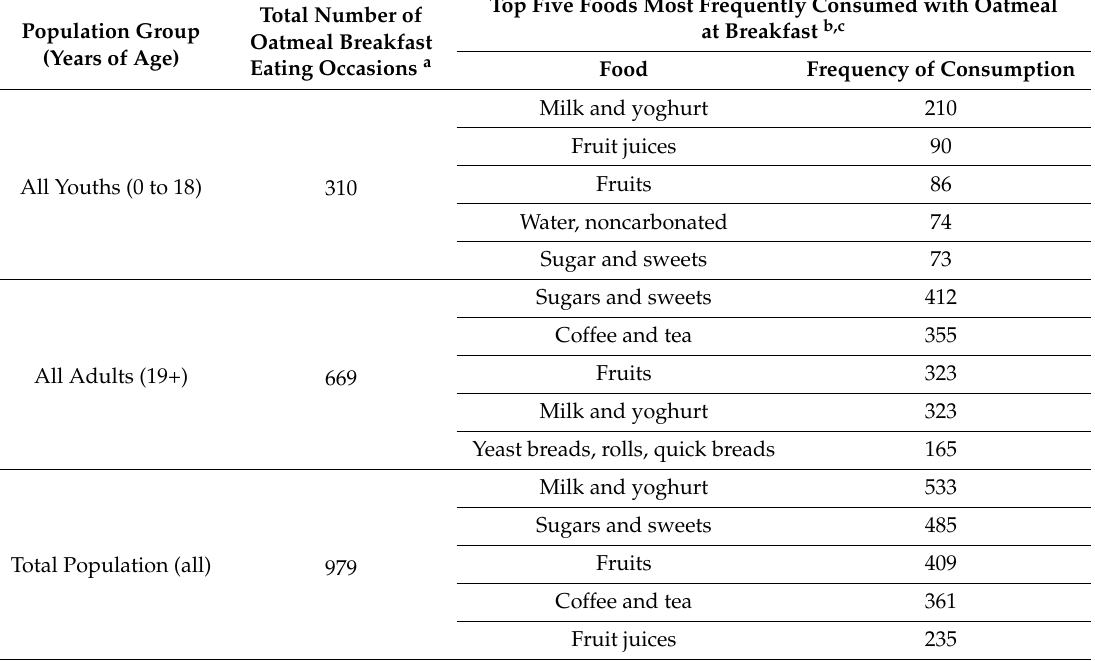
Table 5. Foods co-consumed with cooked oatmeal at breakfast (data from Day 1 of the 2009–2012